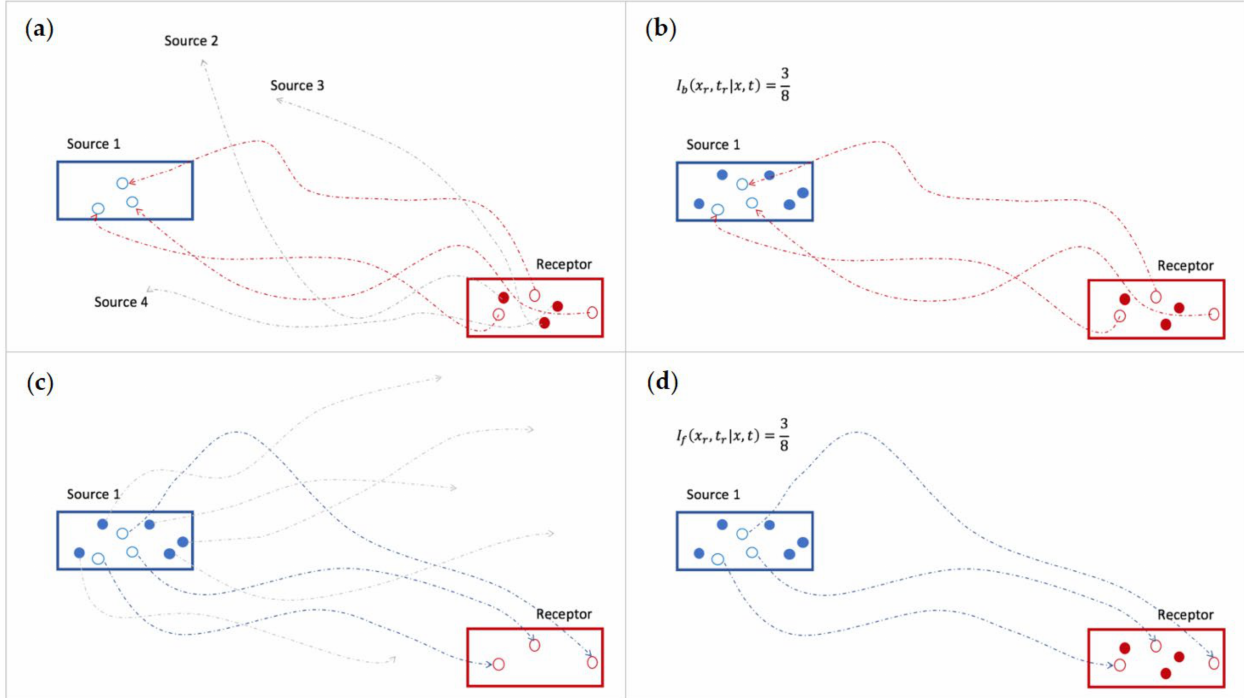
Figure 9. The procedure of the backward–forward stochastic particle tracking model: ( a ) tracing back particles in the receptor grid cell; ( b ) calculating the backward influence function; ( c ) releasing and tracing the particles from the upstream source cell; ( d ) calculating the forward influence